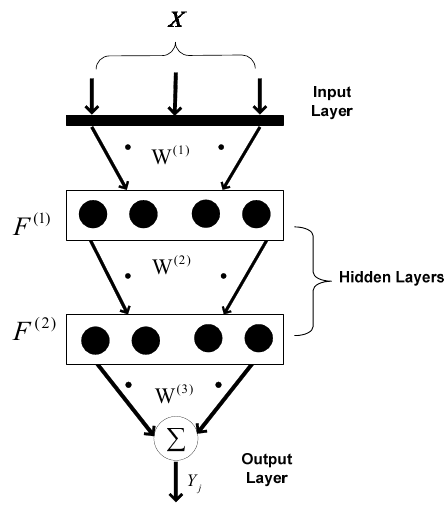
Figure 3. Applied ANN approximation